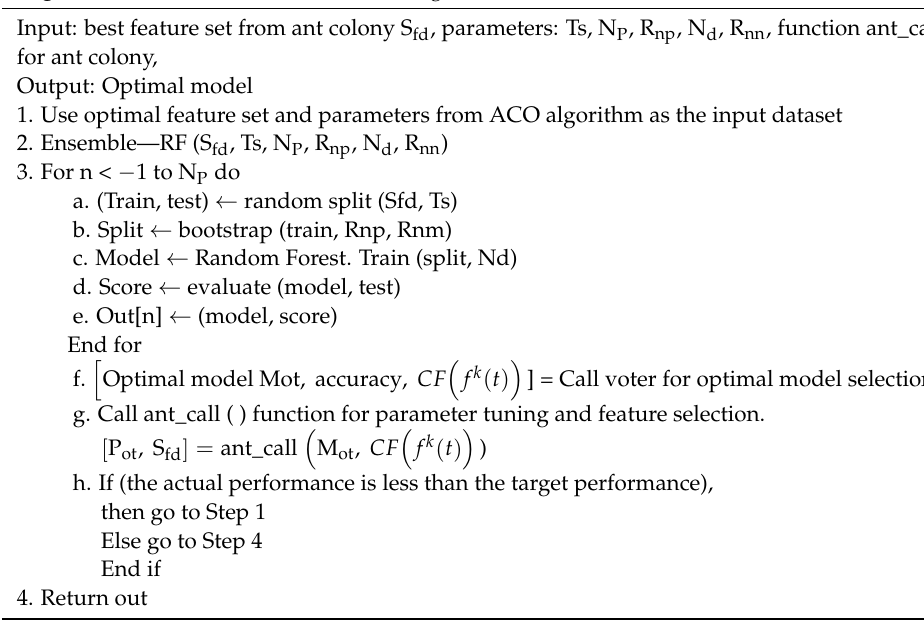
Algorithm 1: Ensemble Random Forest